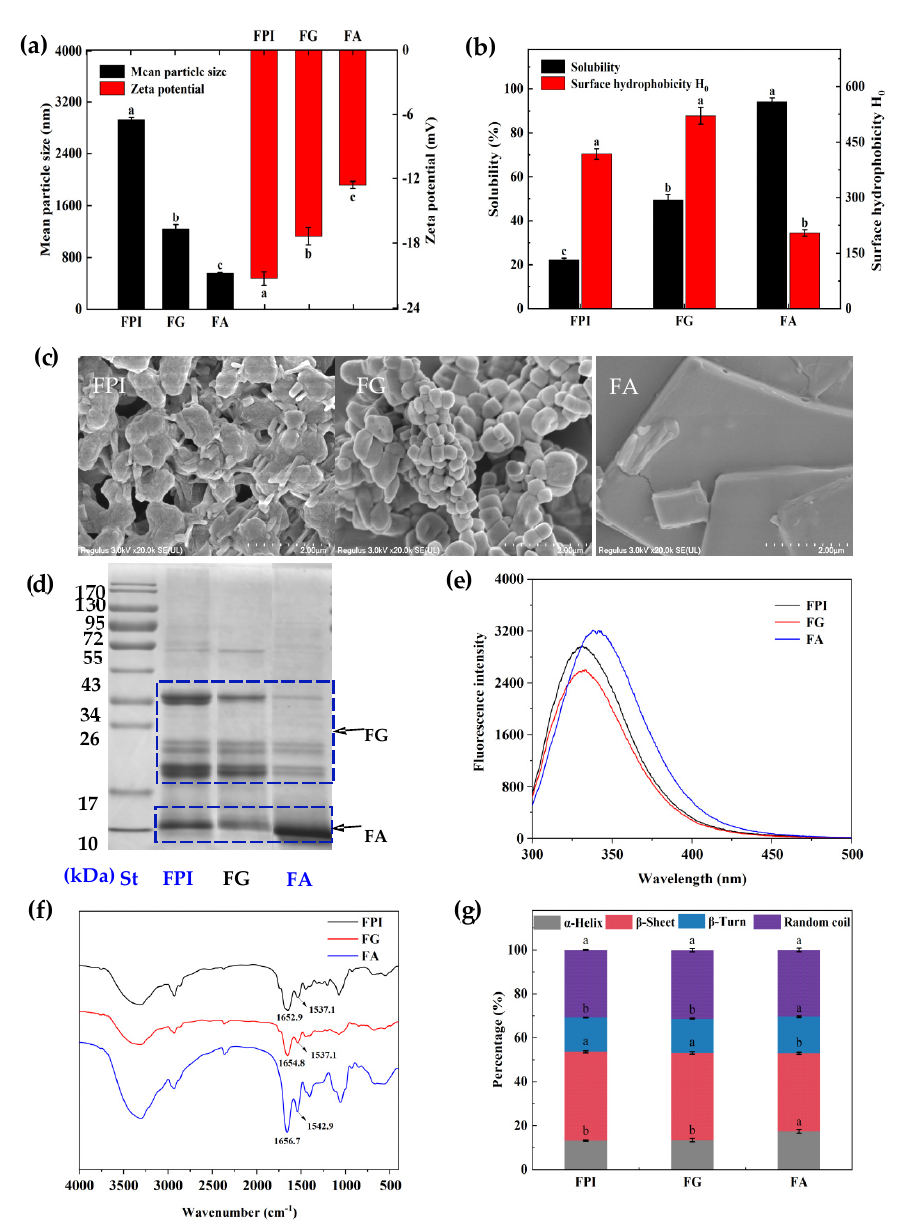
Figure 1. The physicochemical, morphological, and structural properties of FPI, FA, and FG. ( a ): the mean particle size (black bar) and zeta potential (red bar); ( b ): the solubility (black bar) and surface hydrophobicity (red bar); ( c ): the SEM imaging; ( d ): the SDS-PAGE analysis; ( e , f ): the intrinsic fluorescence and FTIR spectra; ( g ): the secondary structure obtained from CD spectra. Different alphabets in same index indicated significant differences at the p < 0.05 level. FPI: flaxseed protein isolate; FG: flaxseed globulin; FA: flaxseed